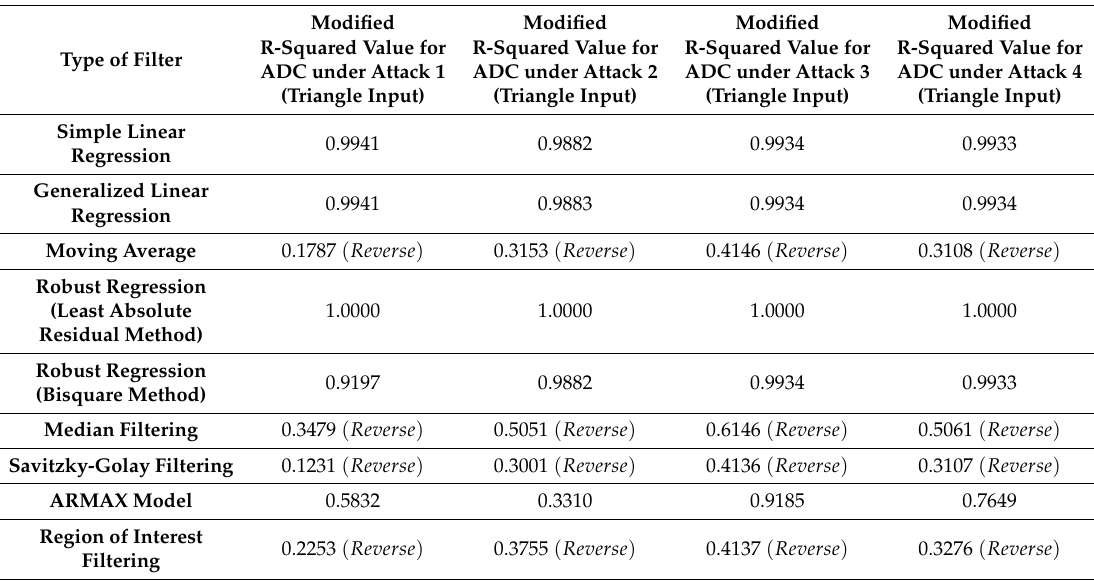
Table 2. Defense Analysis (2): The performance analysis of filters based on their corresponding modified R-squared values when a triangle signal is applied to the modulator.